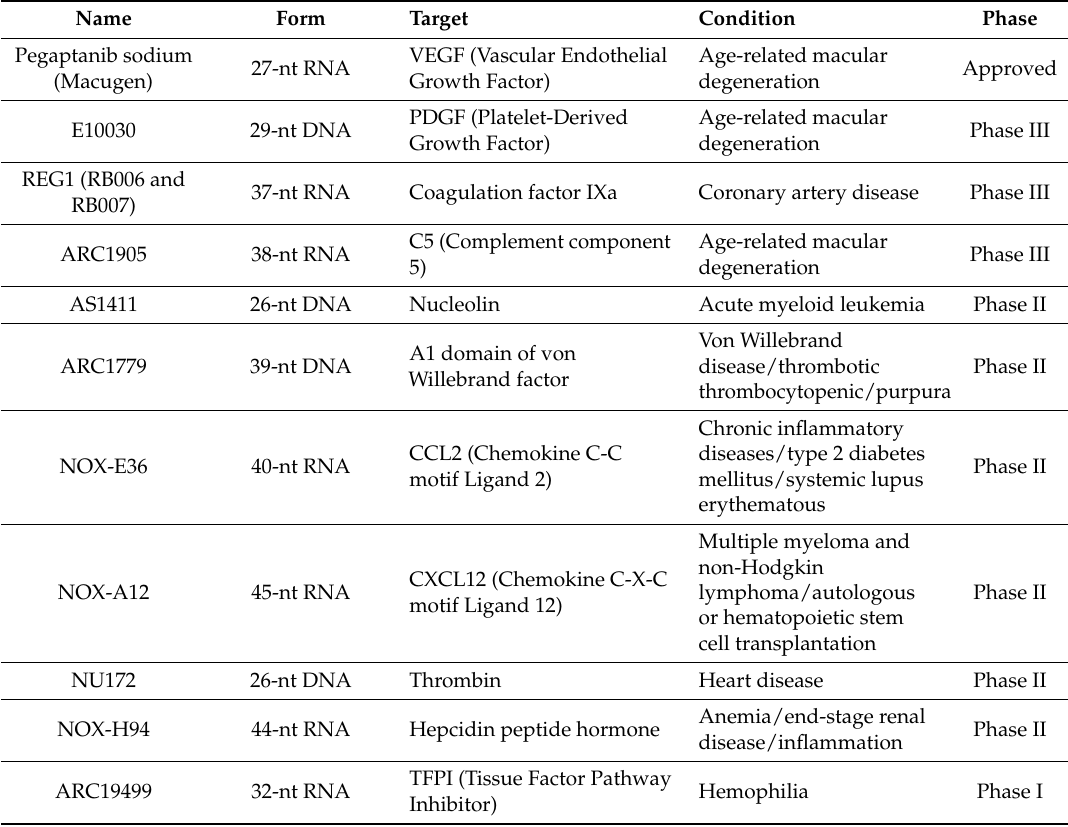
Table 4. Progress of aptamers for diseases’ therapy in on-going or completed clinical